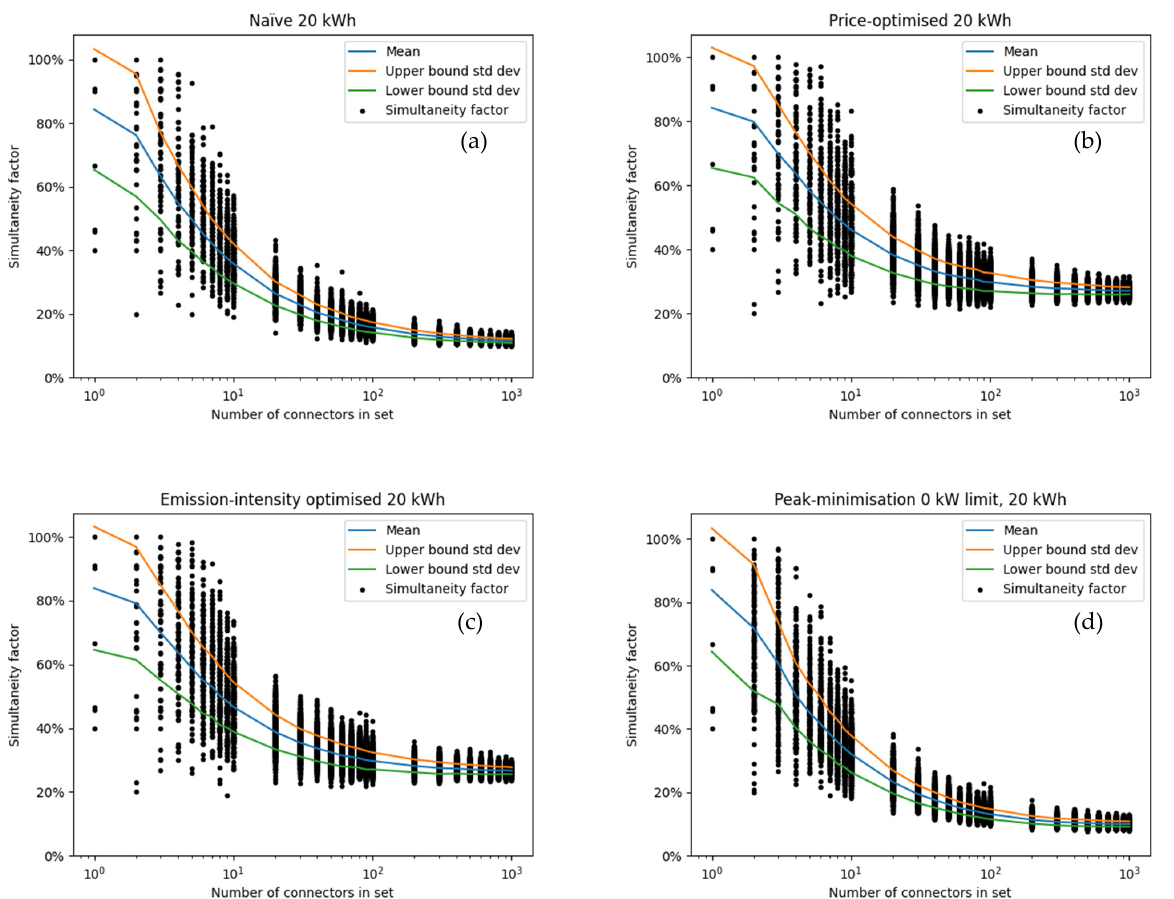
Figure A4. Coincidence factor assuming 20 kWh per CE for ( a ) naive charging; ( b ) price-optimised charging; ( c ) CO 2 intensity optimised charging; ( d ) peak power optimised charging. Note that peak power was optimised for all C simultaneously. Optimizing for each set in ( d ) for a low simultaneity factor likely results in significantly lower values. For the larger sets, the difference is minor. The blue line shows the mean across the randomly selected sets, and the orange and green lines the upper and lower boundaries of the standard deviation. Each randomly selected set was of the size shown on the x -axis.